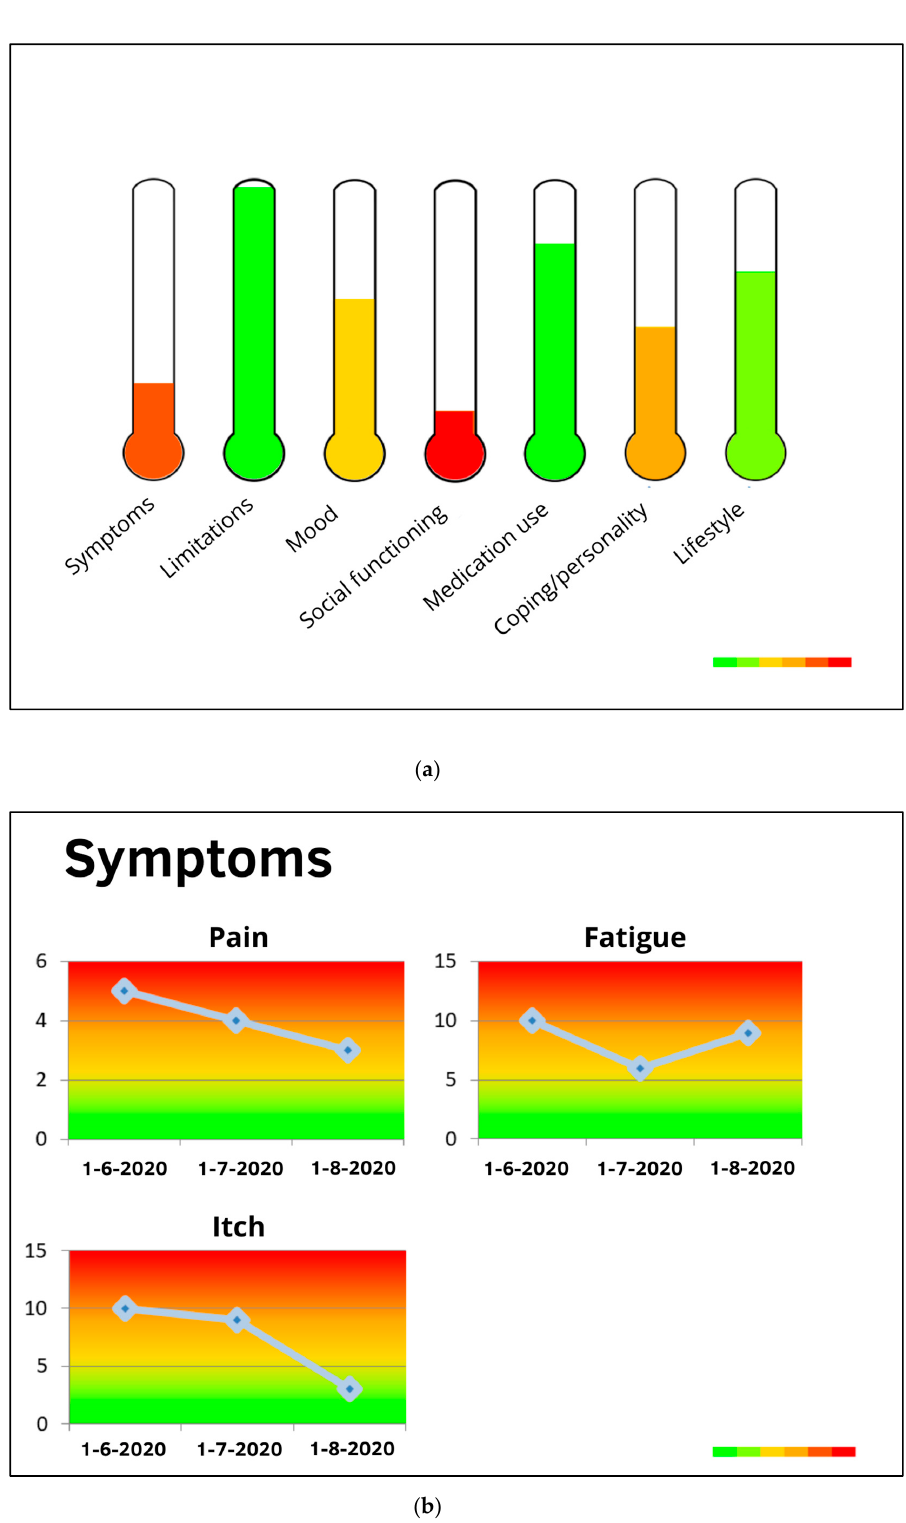
Figure 2. ( a ) Profile chart and ( b ) monitor chart preferred in the first user feedback round.